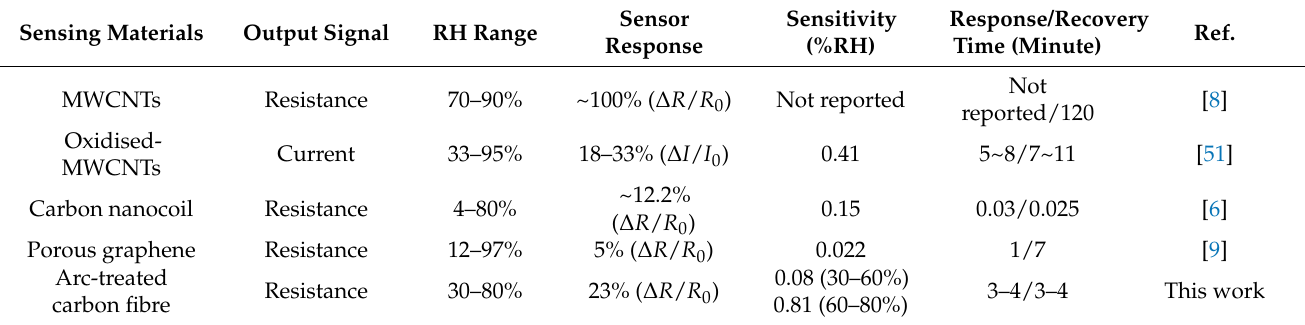
Table 3. Comparison of the humidity sensing performance of different